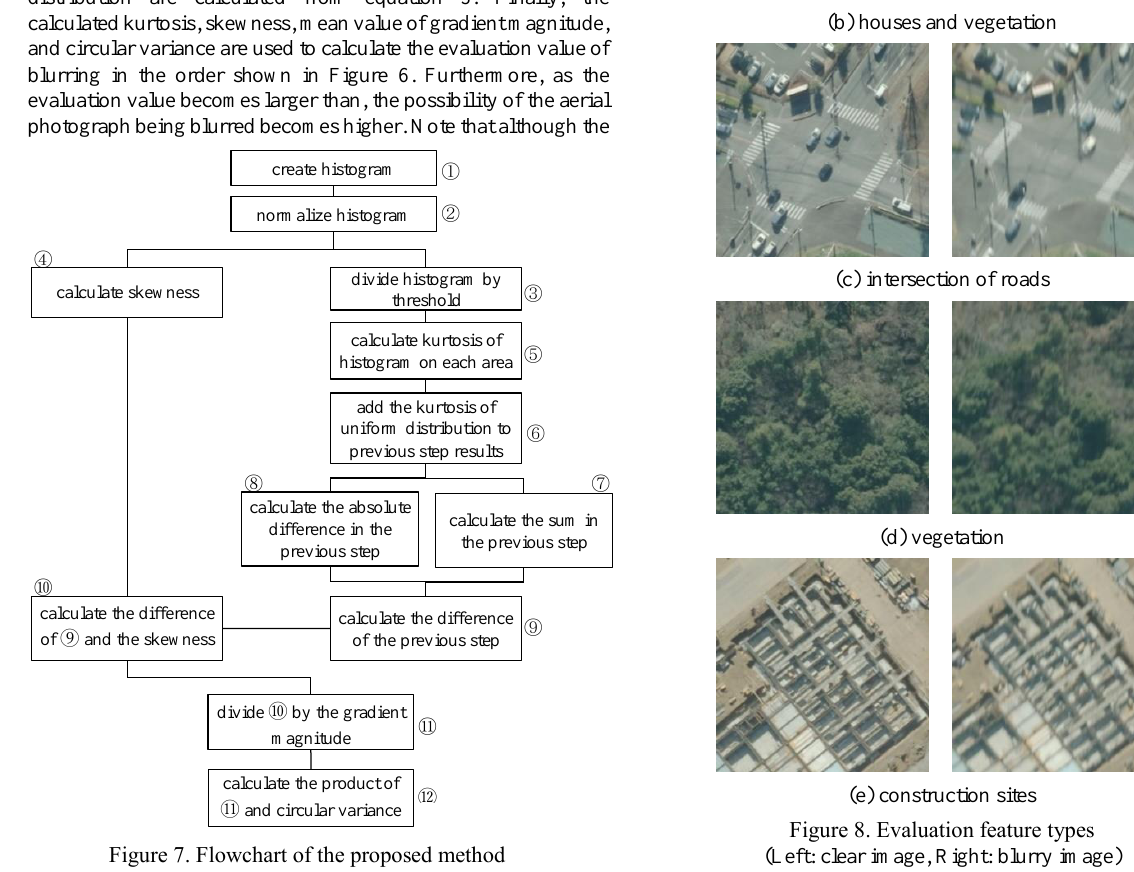
(Left: clear image, Right: blurry image) Figure 7. Flowchart of the proposed